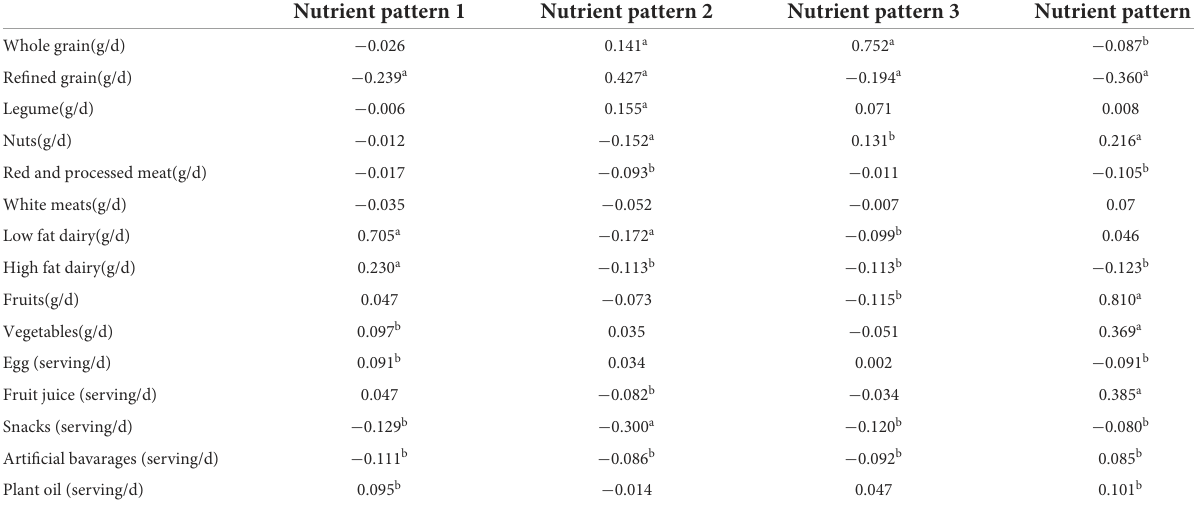
TABLE 3 Partial correlation coefficient of nutrient patterns with food sources * .